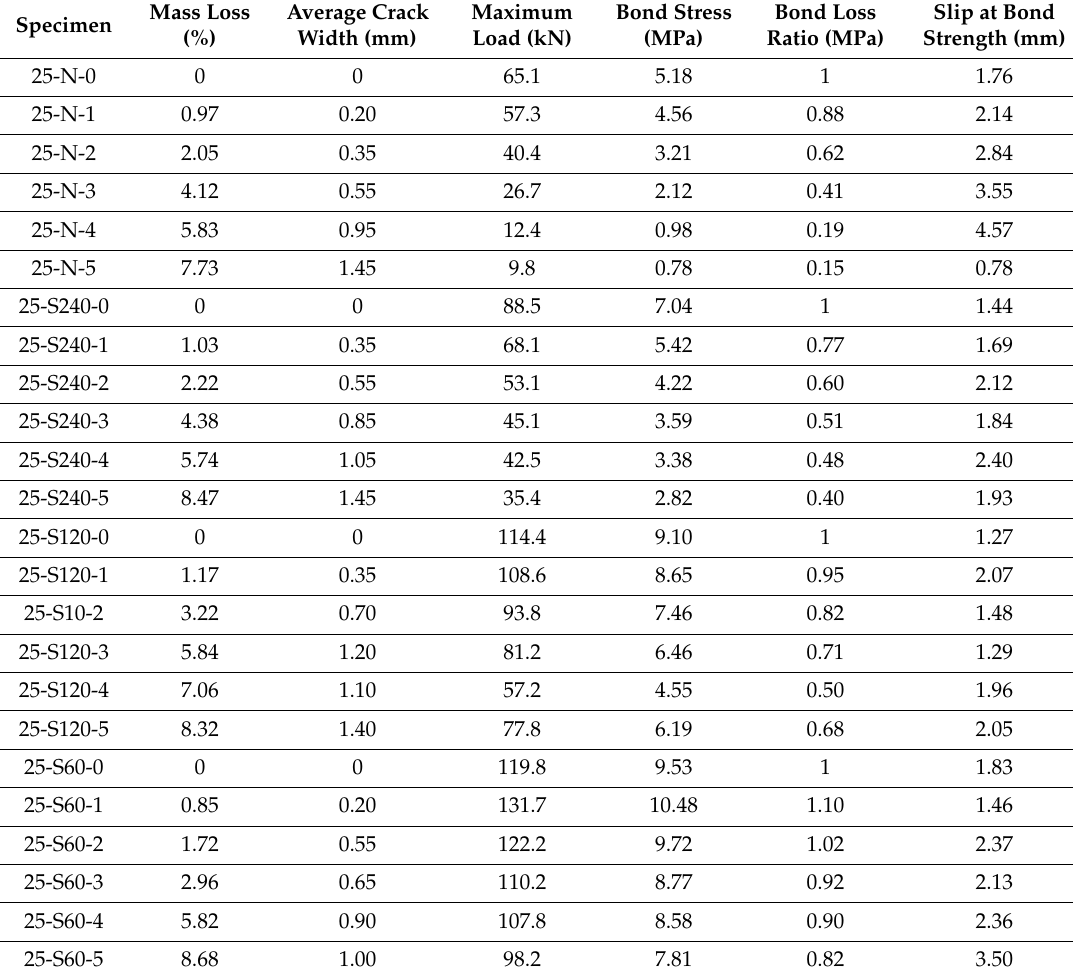
Table 1. Experimental results obtained from accelerated corrosion tests and pull-out tests (mass